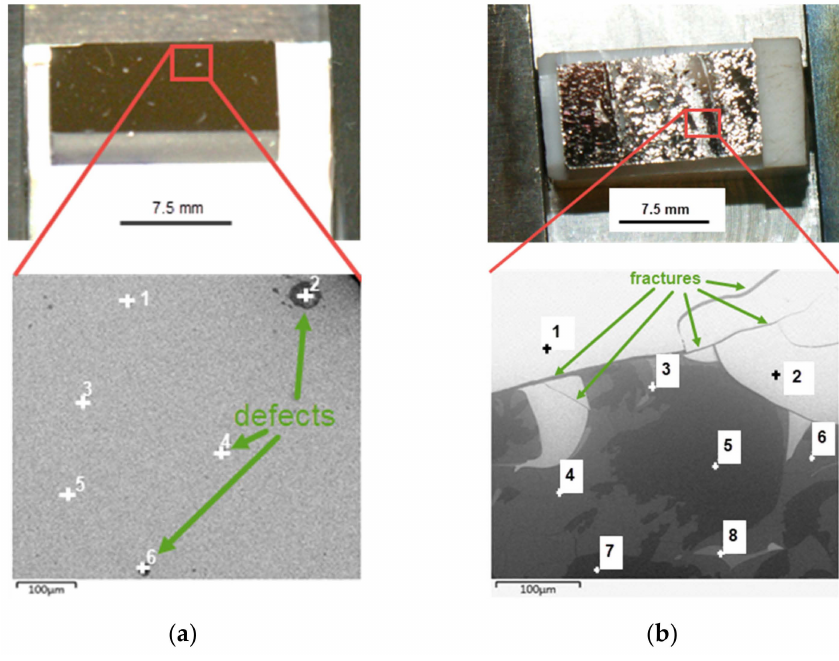
Figure 7. Optical and SEM photos of coatings irradiated in air ( a ) and neon ( b ). Table 3. Elemental composition (at. %) on the surface of coatings irradiated in neon and